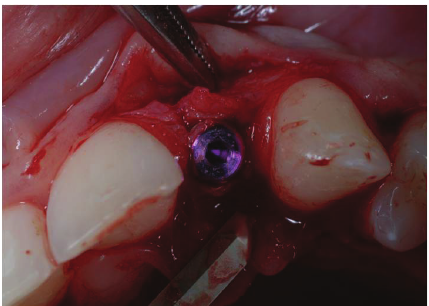
Figure 11: Implant placement in site to the right.